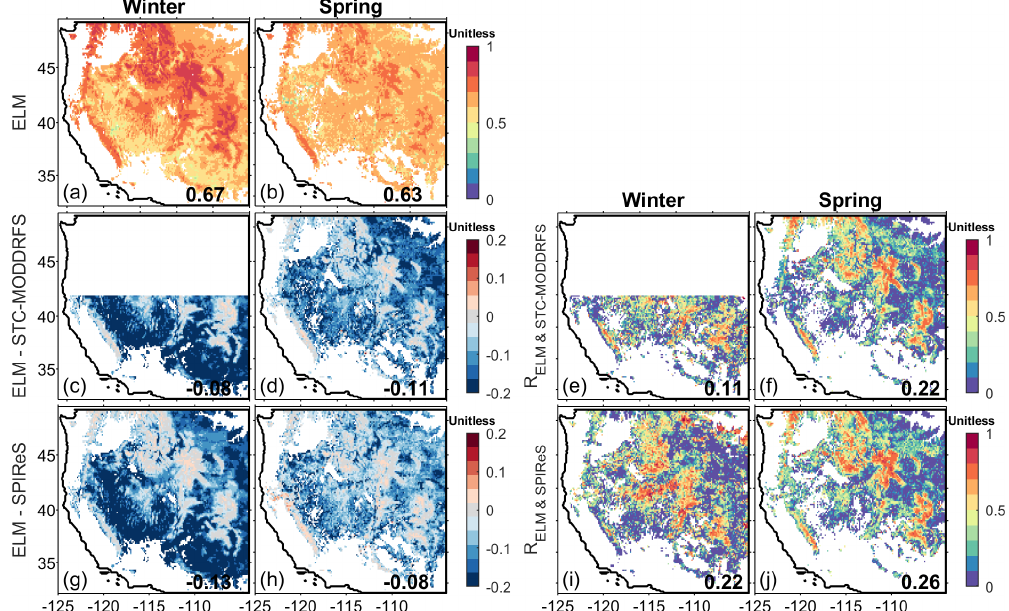
Figure 8. Spatial distributions of (a, b) snow albedo ( α sno ) in ELM, and (c, d, g, h) the α sno difference between ELM and two remote sensing products (i.e., STC-MODDRFS and SPIReS) and (e, f, i, j) their temporal correlations ( R s ) for different seasons: (a, c, e, g, i) winter and (b, d, f, h, j) spring. In all panels, regions with no snow cover are masked with white color. The area-weighted average values are labeled in each panel.